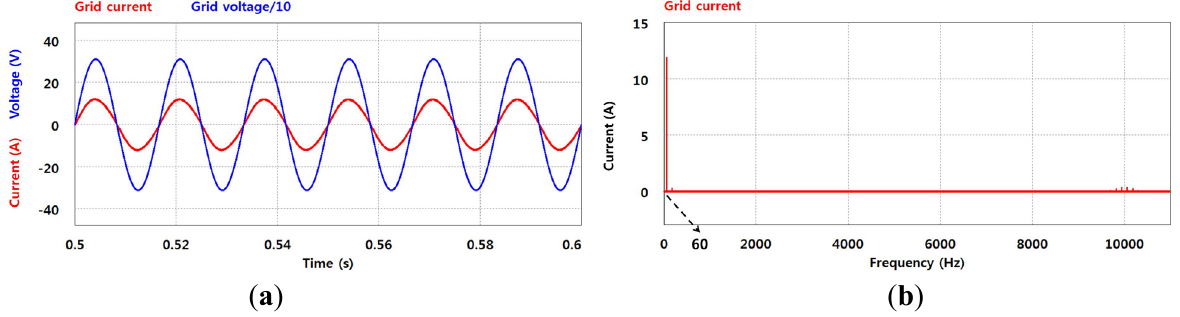
Figure 18. Simulation waveform of the grid current and voltage without compensation.